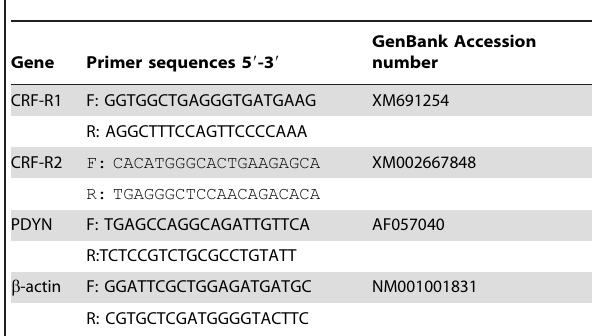
Table 1. Primer sequences used for semi-quantitative